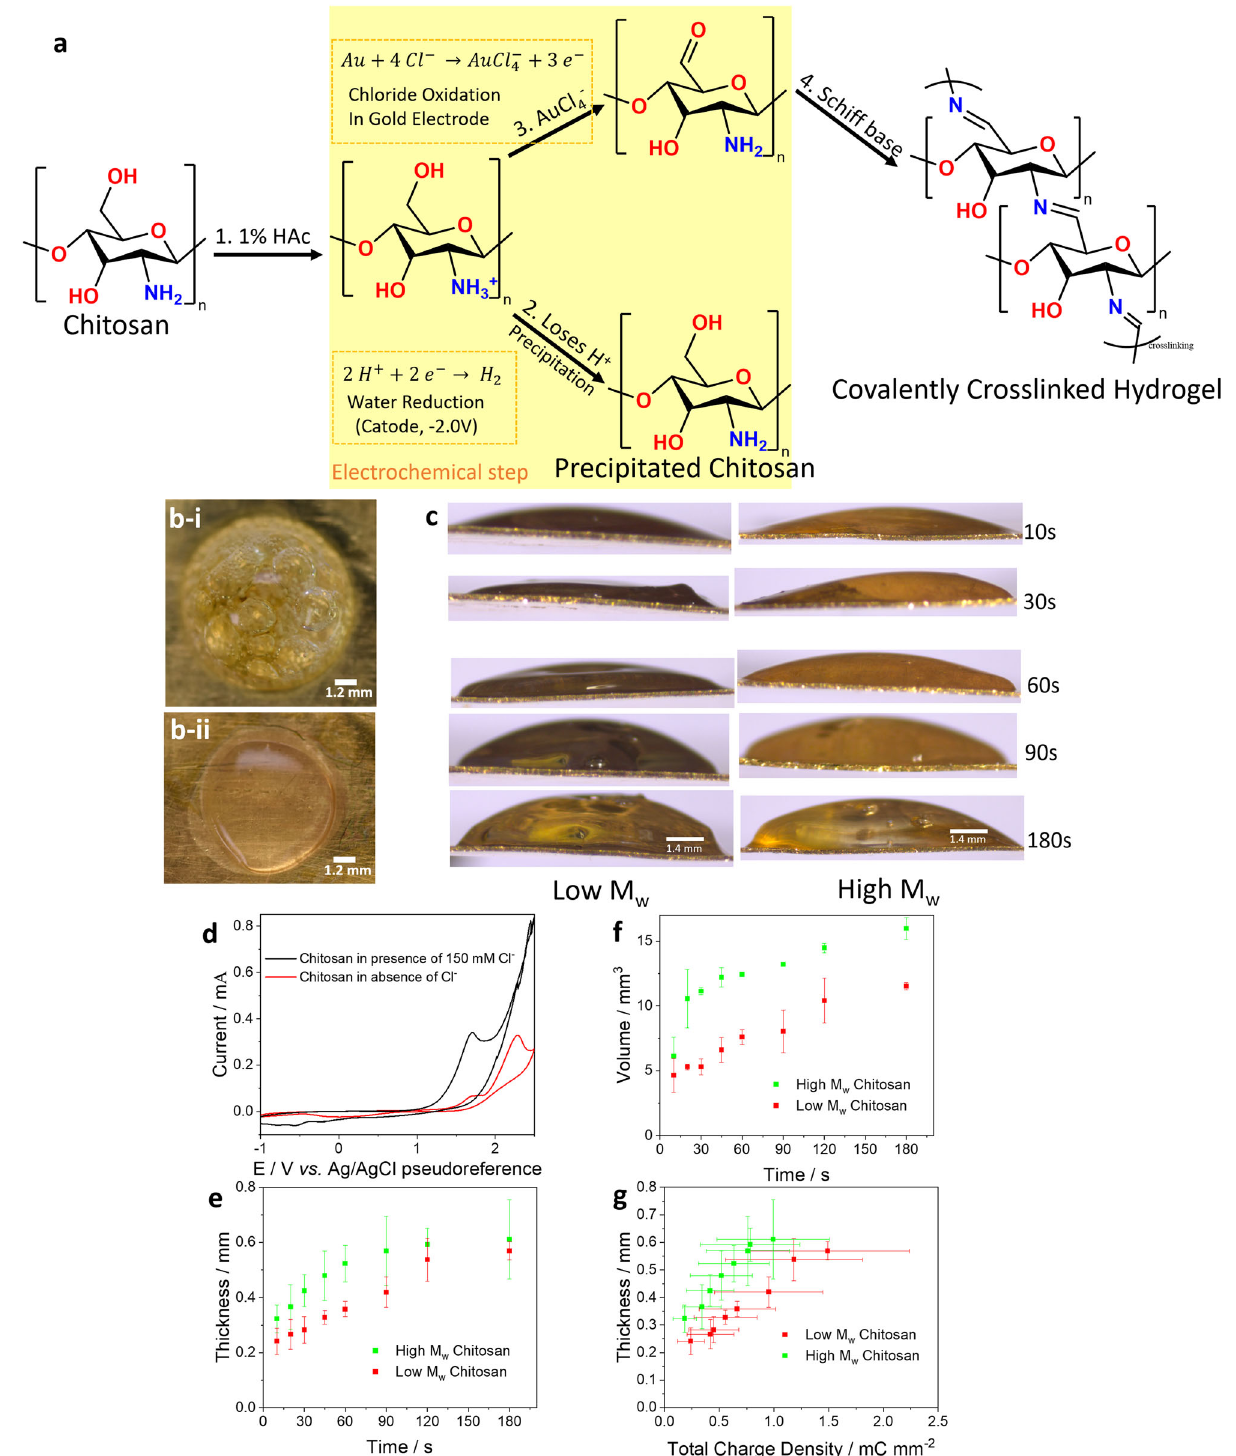
Fig. 2 Reactions and growth pro fi les for chitosan hydrogels. a Schematic representation of the chemical reactions involved in chitosan hydrogel formation, yellow block highlights the electrochemical controlled steps that can lead to precipitated (by water hydrolysis) or covalently crosslinked (gold oxidation in presence of chloride) hydrogels. b Representative picture of the ( i ) precipitated ( − 2.0 V) and ( ii ) covalently crosslinked ( + 1.8 V) high molecular weight ( M w ) chitosan. c Representative pictures (side view) of the growth pro fi le of low and high M w chitosan. d CV of chitosan in presence of 150 mmol L − 1 (black) and absence (red) of chloride in the supporting electrolyte. Chloride was substituted by sulfate. Scan rate was 100 mV s − 1 . e Thickness and f volume growth of high (green) and low (red) M w chitosan as a function of polymerisation. The applied potential is + 1.8 V vs Ag/AgCl. g Relationship between thickness and total charge density supplied to promote the gelation reaction for high (green) and low (red) M w chitosan. Thickness, volume and total charge density here are measured quantities with the error bars representing the mean ± standard deviation ( n = 3 independent electrodeposition